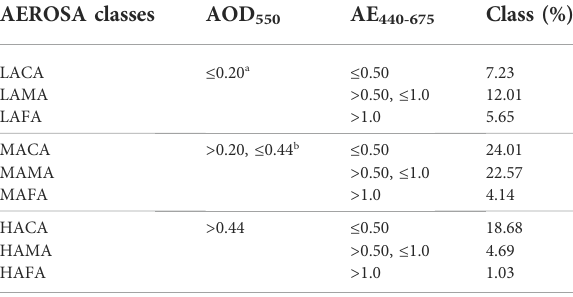
TABLE 8 The percentage of AEROSA generic classes in Saudi Arabia using AERONET data from 1999 to 2020. The thresholds used for the AEROSA approach over Saudi Arabia are presented in the second and third